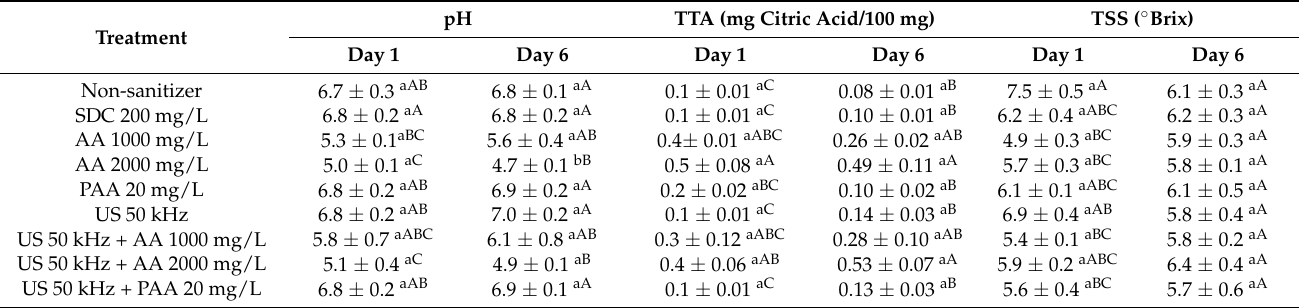
Table 2. Average and standard deviation of pH, total titratable acidity, and total soluble solids in kale samples after sanitization and over storage at 7 ◦